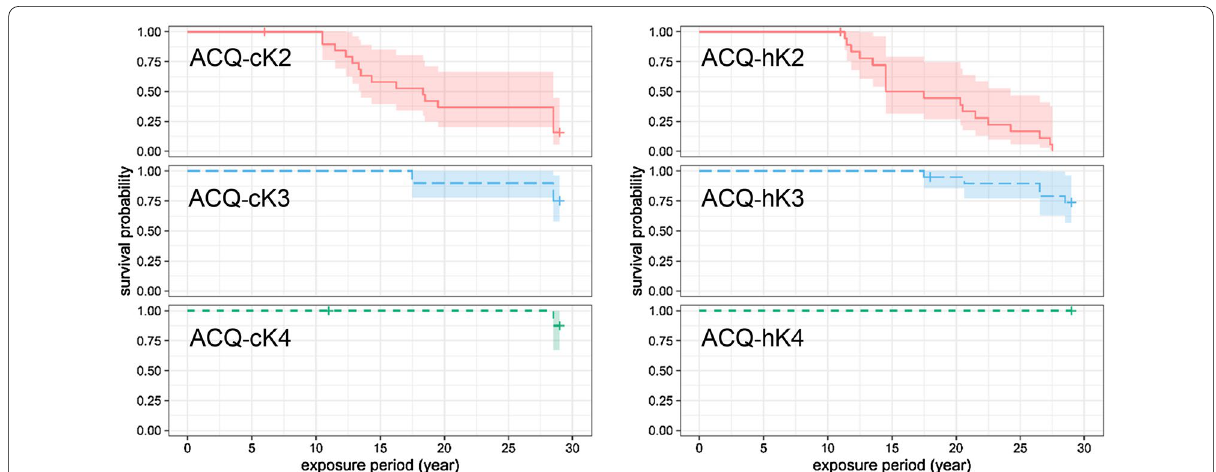
Fig. 5 Kaplan–Meier curves for stakes impregnated with ACQ-1 at the Ibaraki site. Left: Japanese cedar stakes. Right: western hemlock stakes. Information on the stakes in each performance classification is shown in Table 1. ACQ-1 alkaline copper quaternary